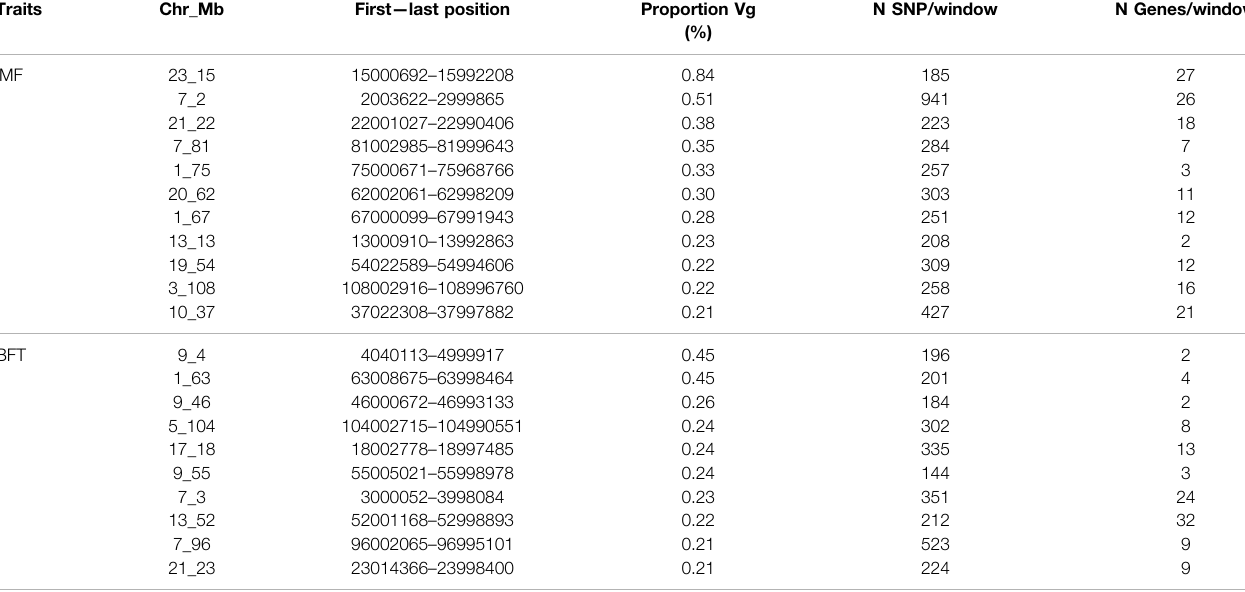
TABLE 1 | Characterization of the relevant QTL regions associated with intramuscular fat content (IMF) and backfat thickness (BFT) in a Nellore cattle population.